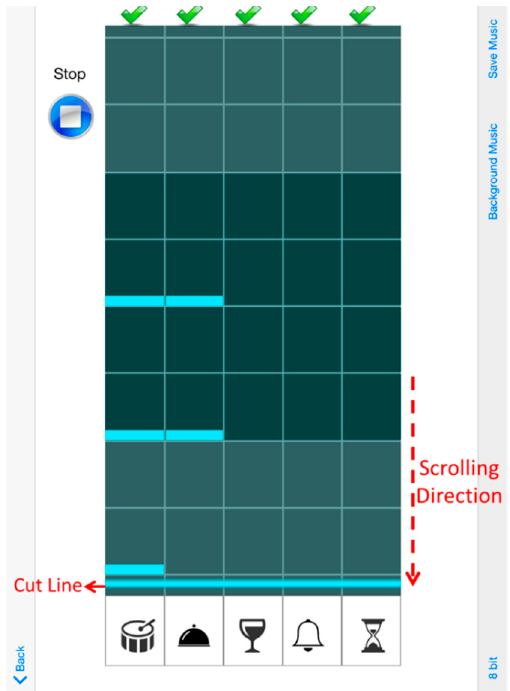
Figure 4. An edited score is played by the rhythm teaching system.